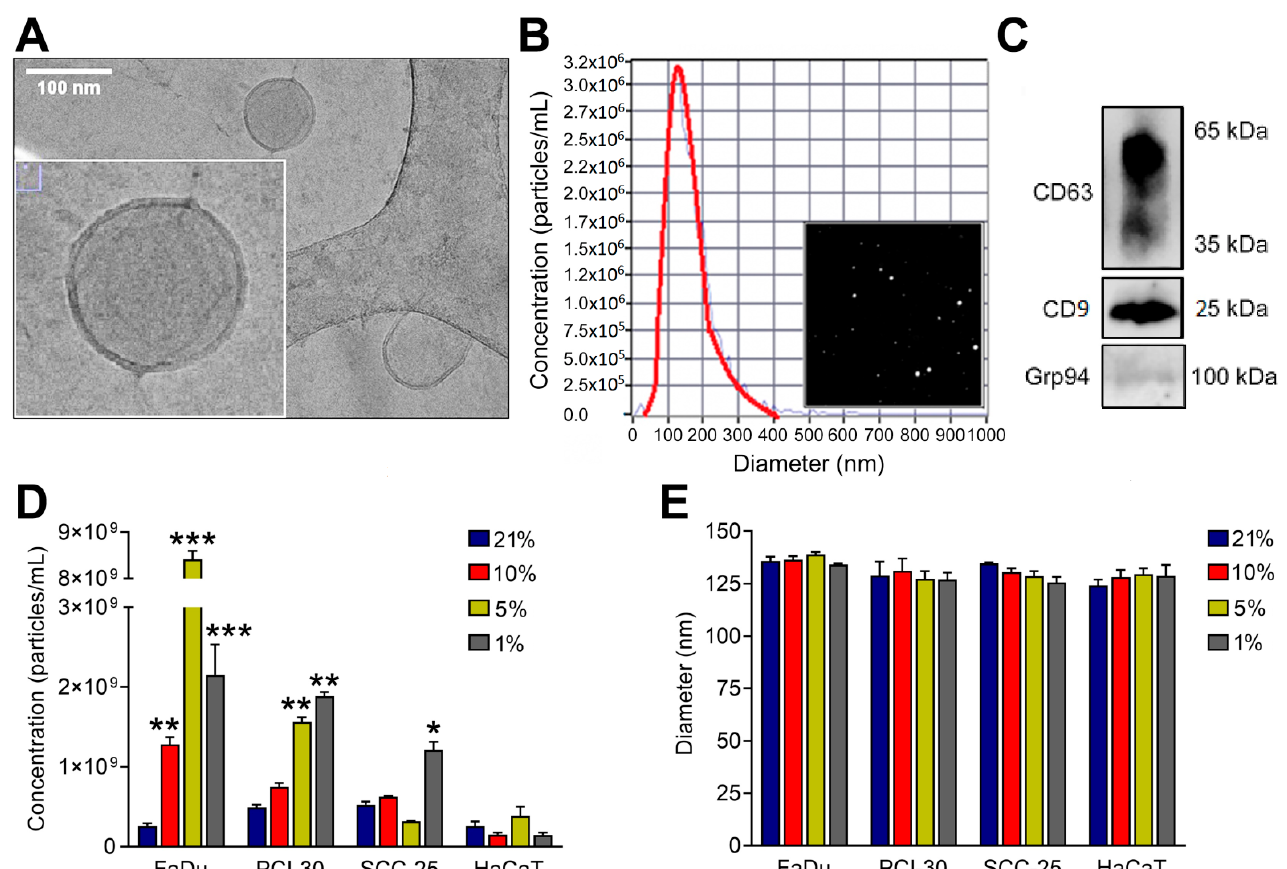
Figure 1. Characterization of small extracellular vesicles (sEVs) derived from human Head and Neck Squamous Cell Carcinoma cell lines: FaDu (hypopharyngeal squamous cell carcinoma), PCI-30 (tongue squamous cell carcinoma), SCC-25 (tongue squamous cell carcinoma); and sEVs derived from HaCat (immortalized human keratinocytes). ( A ) Representative cryogenic transmission microscopy image of HNSCC cell-derived sEVs. ( B ) Representative concentration and size distribution plot of HNSCC-derived sEVs measured by nanoparticle tracking analysis (NTA) and particle visualization based on Brownian motions. ( C ) Immunoblotting of sEV markers CD63, CD9, and negative marker Grp94 in HNSCC-derived sEVs. Full blot images are presented in Figures S2–S4. ( D ) Particle concentration related to normoxic (21% O 2 ) and hypoxic (1% O 2 , 5% O 2 , 10% O 2 ) conditions. Results were obtained using NTA and normalized to the protein levels in lysates of producer cells. ( E ) Particle diameter related to normoxic (21% O 2 ) and hypoxic (1% O 2 , 5% O 2 , 10% O 2 ) conditions. Results were obtained using NTA. All data represent three biological replicates and are presented as means ± SD. * p < 0.05 vs. 21%; ** p < 0.01 vs. 21%; *** p < 0.001 vs. 21%.